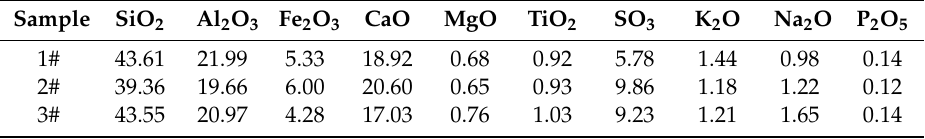
Table 5. Chemical compositions (wt %) of Shenhua bituminous coal with di ff erent particle sizes. Sample SiO